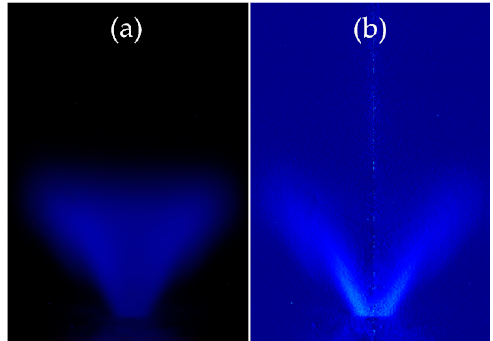
Figure 4. CH chemiluminescence of the OF30 flame at equivalence ratio ( Ф ) = 0.72, with a preheating temperature of 466.15 K: ( a ) directly acquired CH image; ( b ) the reconstructed CH image using the inverse Abel transform for an axisymmetric cross-section of the flame.